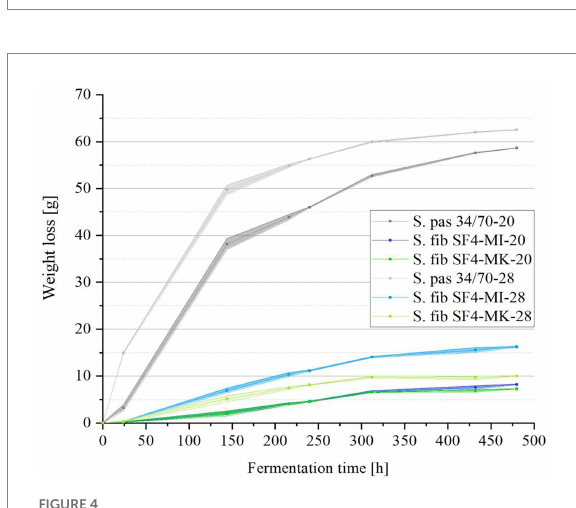
FIGURE 4 Mean values ( n = 3) with standard deviations of the fermentation samples’ total weight losses in grams of the investigated yeast strain S. fib SF4 as micromanipulated (MI) and mother culture (MK) and the reference yeast strain S. pas 34/70 during the fermentation process over a fermentation period of 480 h (20 days) at 20 and 28 °